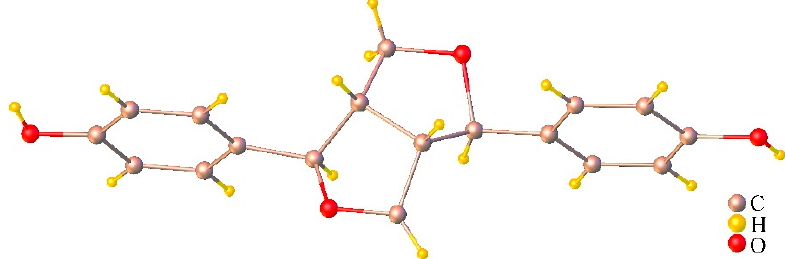
Figure 8. ORTEP plot of the X-ray crystal structure for ligballinol.